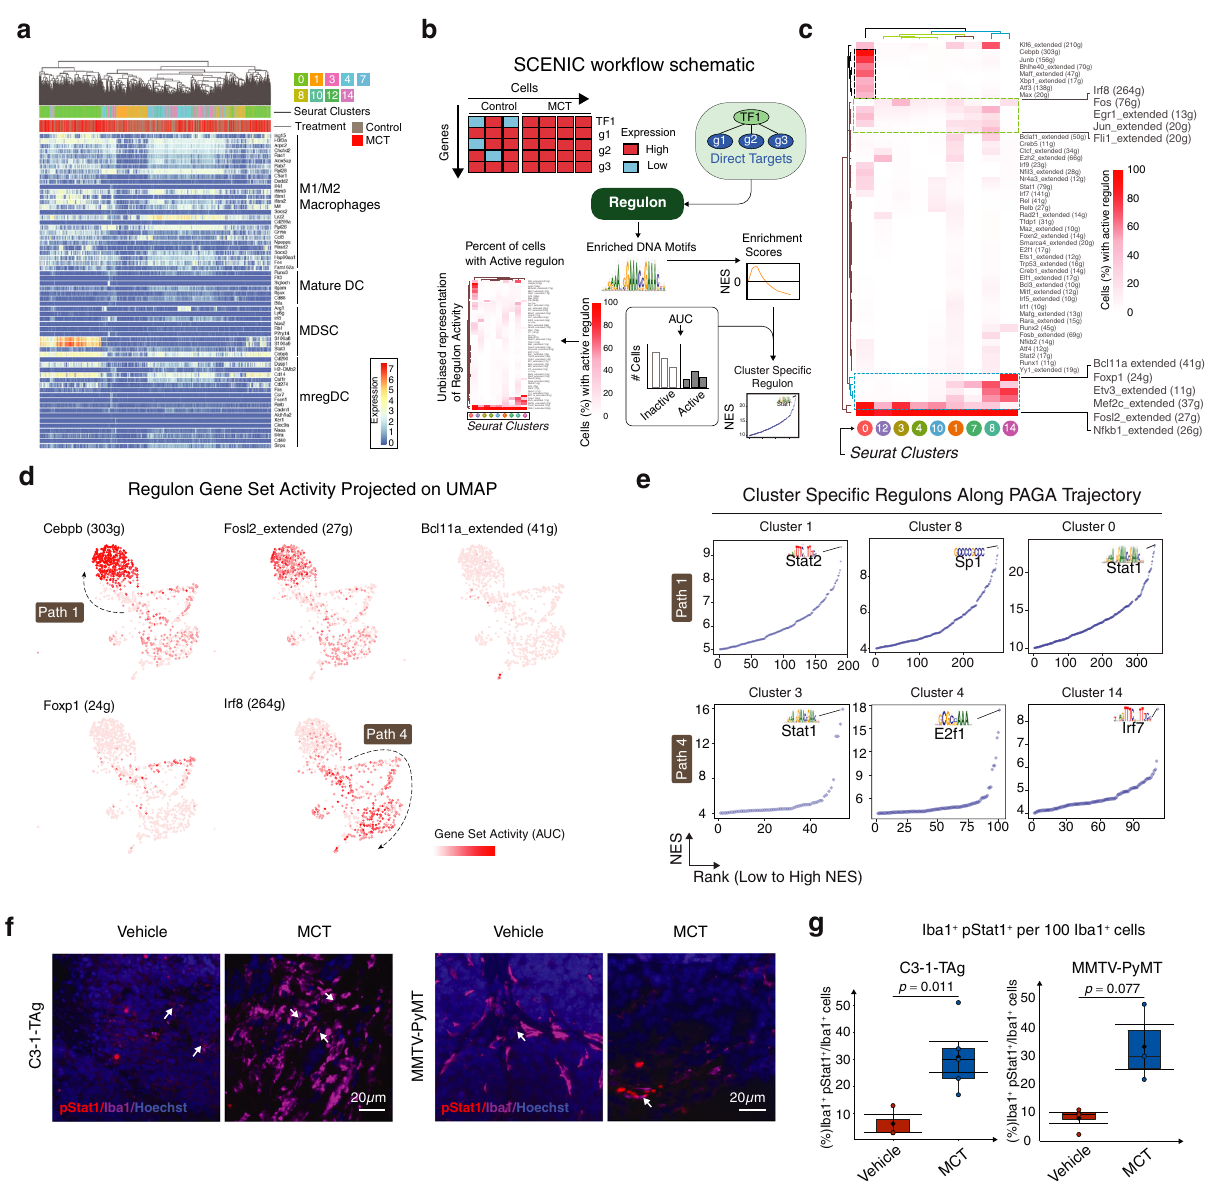
Fig. 3 | Mapping tumor-associated myeloid cell transcriptome regulatory net- worksusingSingle-cellRegulatoryNetworkInferenceandClustering(SCENIC). a HeatmapshowsexpressionofindicatedcelltypemarkergenesbymyeloidSeurat clusters. b SchematicshowsSCENICwork fl ow. c Heatmapshowspercentofcellsin a cluster with active regulon. d UMAP projects the regulon gene set activity. e Scatterplotsshowregulonsspeci fi cto(toprow)Clusters1,8,and0(lefttoright), (bottom row) Clusters 3, 4, and 14 (left to right) and their NES. Each dot is a representative of one NES(see Methods). f Representative IF images ofmurine C3-